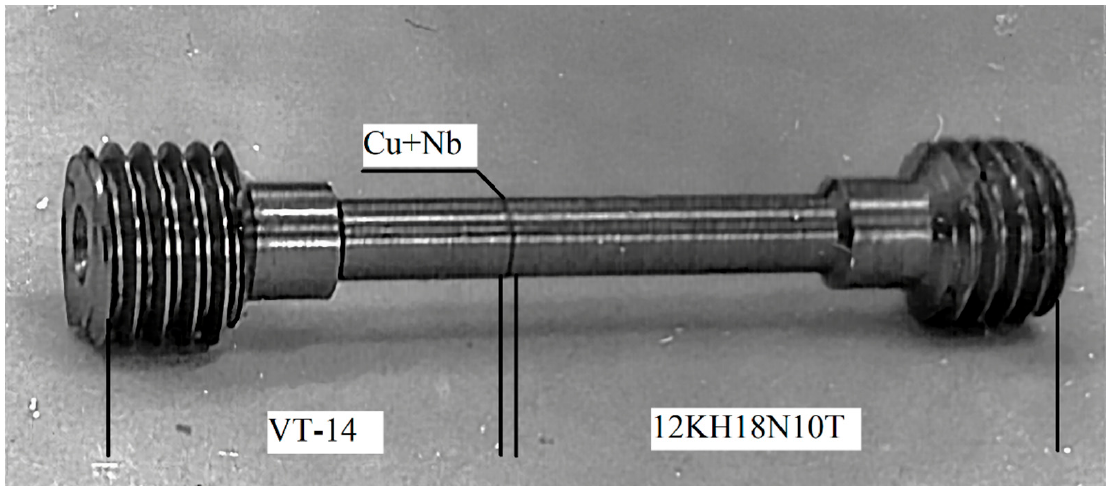
Figure 4. Standard sample No. 4 for mechanical tests turned from a 12KH18N10T+Cu+ Nb+VT-14 billet.